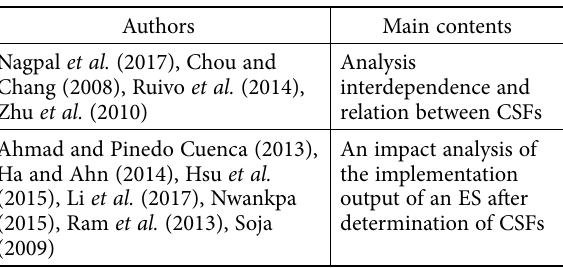
Figure 1. Composition of the process map Table 1. Previous studies related to